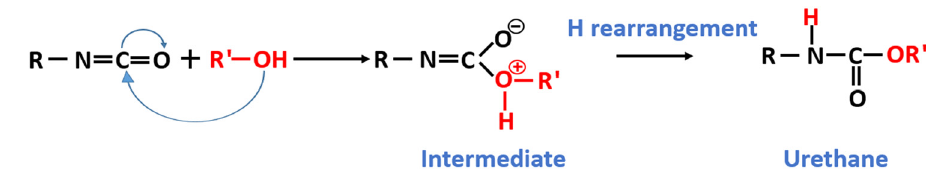
Figure 3: Reaction of an isocyanate with alcohol.